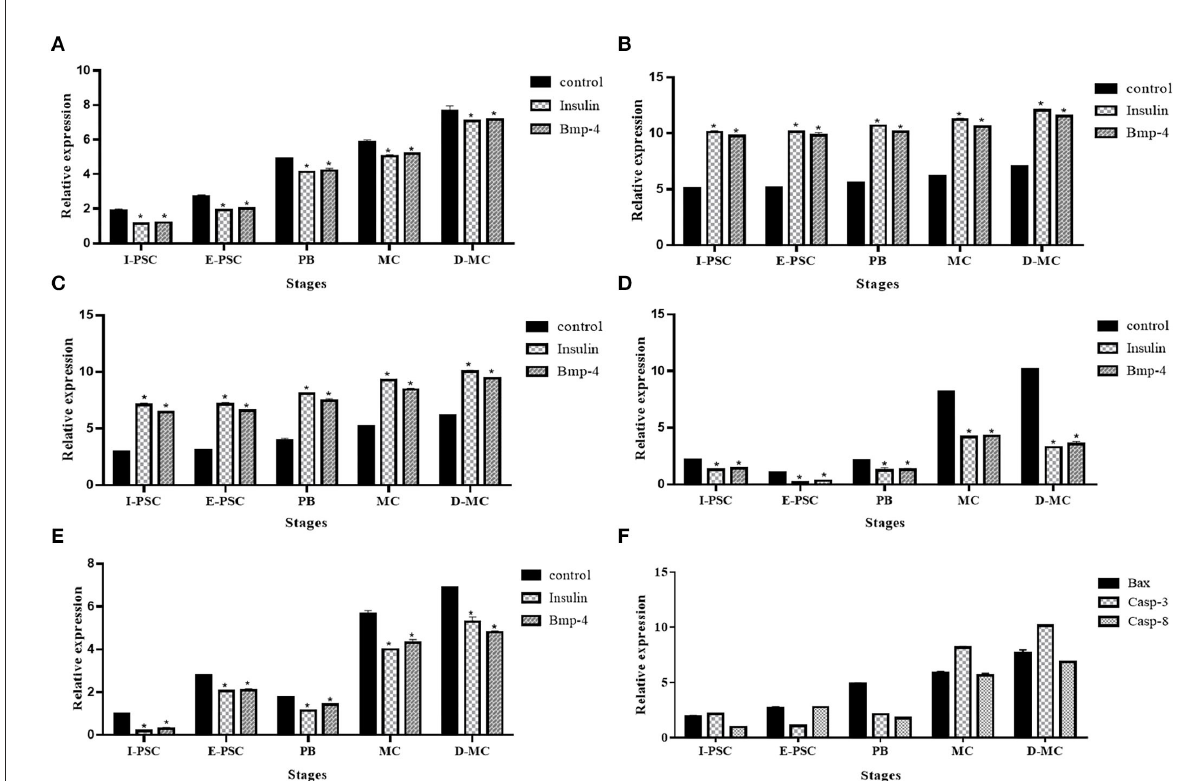
FIGURE6 Expression profile of five genes, (A) BAX, (B) Bcl-2, (C) Caspase-3, (D) Caspase-8, (E) TNF- α , related to apoptosis in different in vitro developmental stages of Echinococcus granulosus treated with insulin and BMP-4 compared to the control using RT-qPCR. I-PSC, Invaginated protoscoleces; E-PSC, Evaginated protoscoleces; PB, Posterior Bladder; MC, Microcyst; D-MC, Deformed Microcyst. Bars show the mean ± standard deviation (SD) derived from duplicate experiments. (F) pro-apoptosis genes in control group (* P <